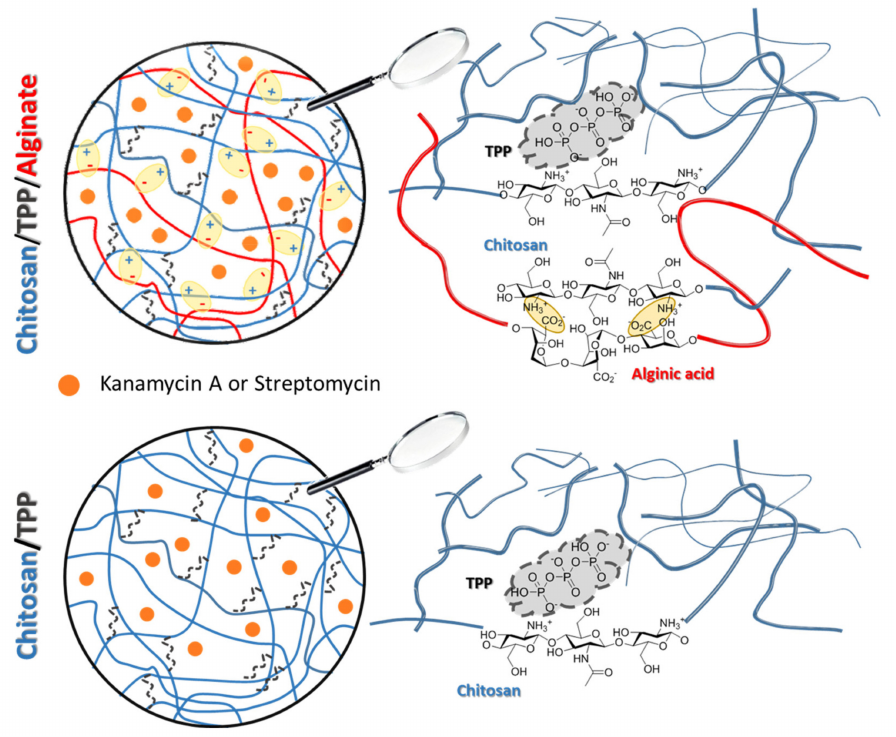
Figure 5. Graphical view of the Alg-coated chitosan/TPP and chitosan/TPP